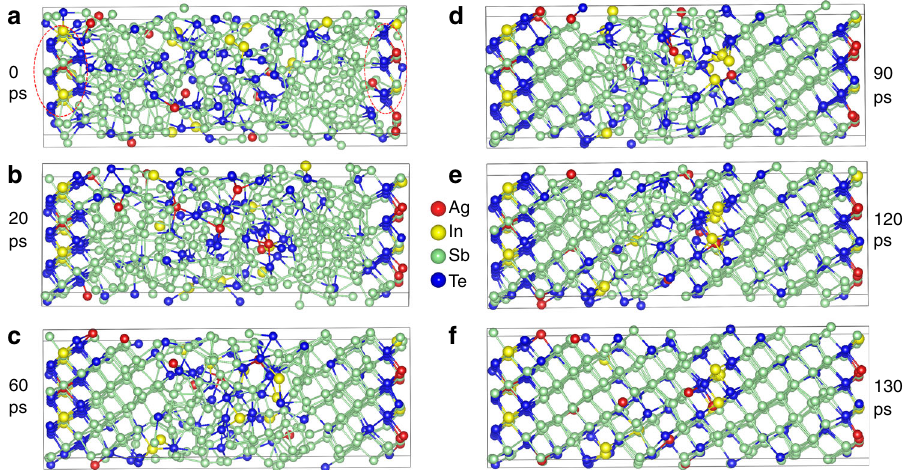
Fig. 6 Structural evolutions of the crystallization process in AIST. a – f snapshots of the crystallization process of AIST at 0, 20, 60, 90, 120, and 130 ps ( T = 600 K). Red circles highlight the introduced crystalline precursor made of Ag/In-Te cubes (45 Fig. 2 and Supplementary Fig. 3. Subsequent short-order atom diffusion processes would occur to achieve the energetically